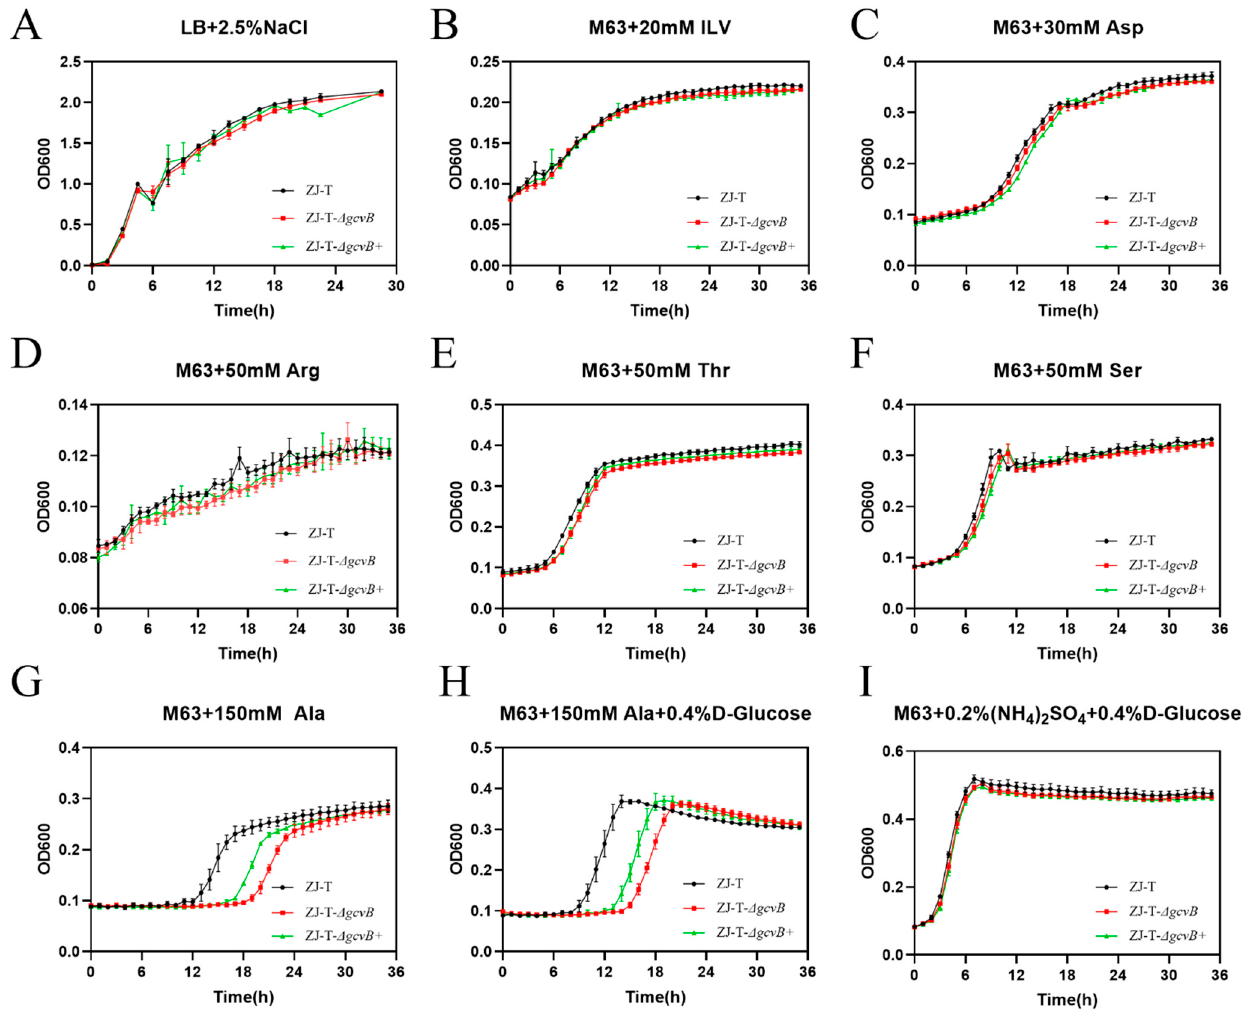
Figure 3. Growth curves of wildtype, gcvB knockout and complementary strains under different nutrient conditions. Growth curves of the wild type, gcvB knockout and complementary strains grown in LB + 2.5% NaCl rich medium( A ), minimal medium M63 which D ‐ glucose and (NH 4 ) 2 SO 4 were left out and replaced by the amino acids: branched chain amino acids (20 mM isoleucine, 20 mM leucine and 20 mM valine), ( B ) 30 mM L ‐ Aspartic acid, ( C ) 50 mM L ‐ Arginine, ( D ) 50 mM L ‐ threonine, ( E ) 50 mM L ‐ serine, ( F ) and 150 mM L ‐ Alanine ( G ) as the sole carbon and nitrogen sources. Growth curves of M63 containing (NH 4 ) 2 SO 4 and 150 mM L ‐ Alanine, ( H ) M63 plus (NH 4 ) 2 SO 4 plus D ‐ glucose ( I ). For growth curves, three biological replicates are shown as points with their average values connected by lines. Error bars indicate the standard deviations (SD).